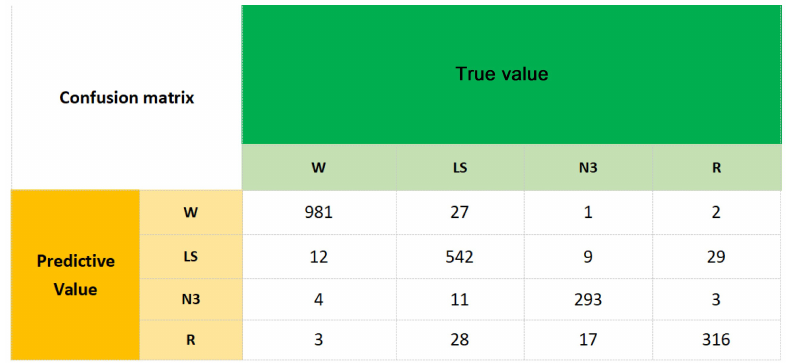
Figure 4. Confusion matrix of Sleep-EDF database 4 classification.